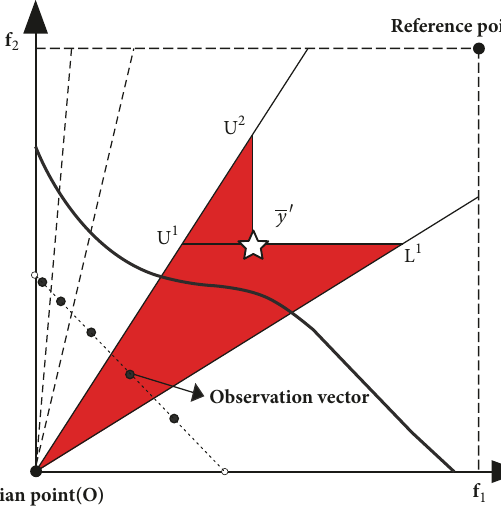
Figure 3: Biased cone decomposition in geometric